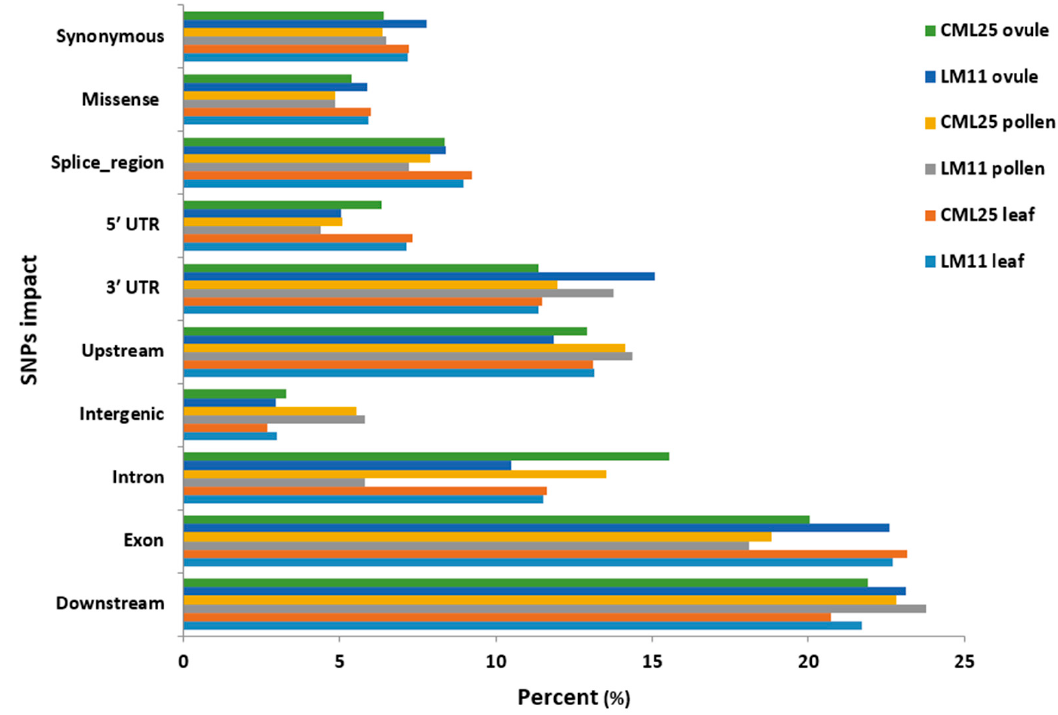
Figure 6. SNPs impact on the functionality of genes predicted in leaf, pollen and ovule of CML25 and LM11 using the SnpEff tool.